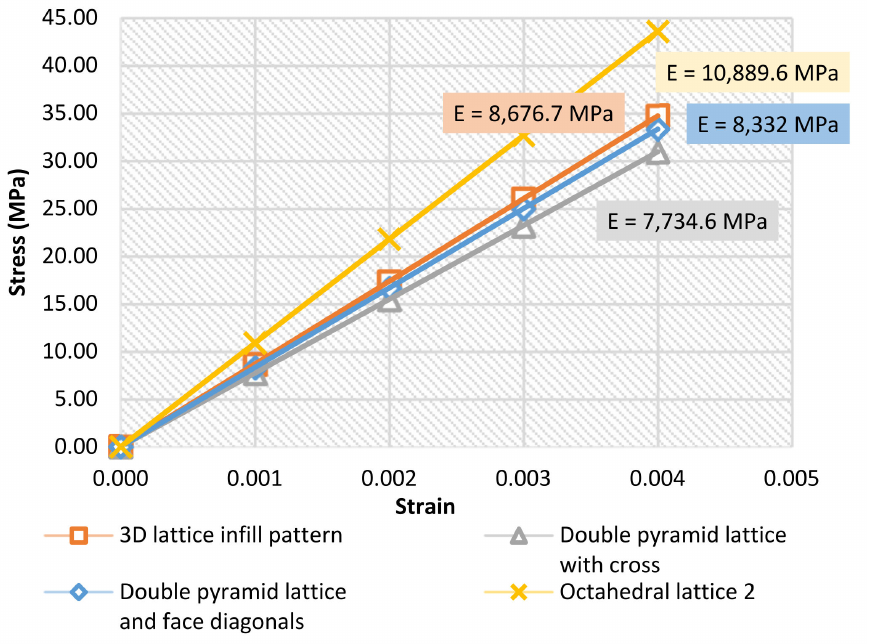
Figure 7. Average stress–strain curves and the average effective Young’s modulus of the